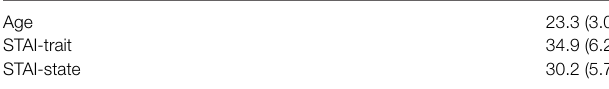
TABLE 3 | Mean ( + SD) of participant